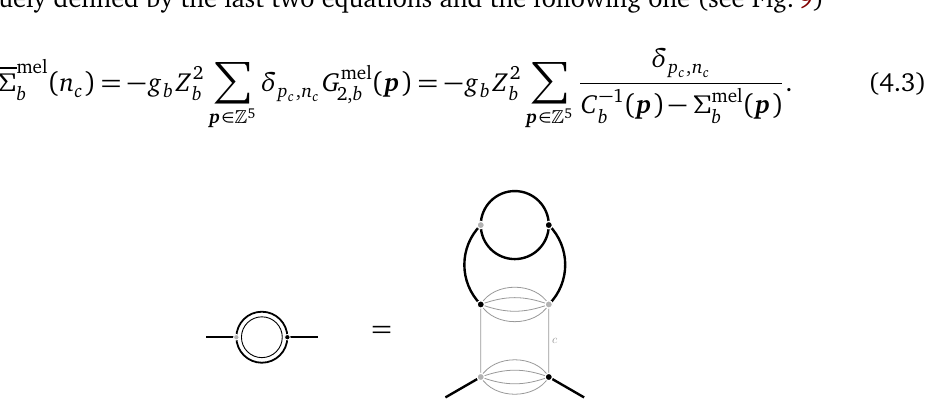
mel and Σ . A circle b 2, b